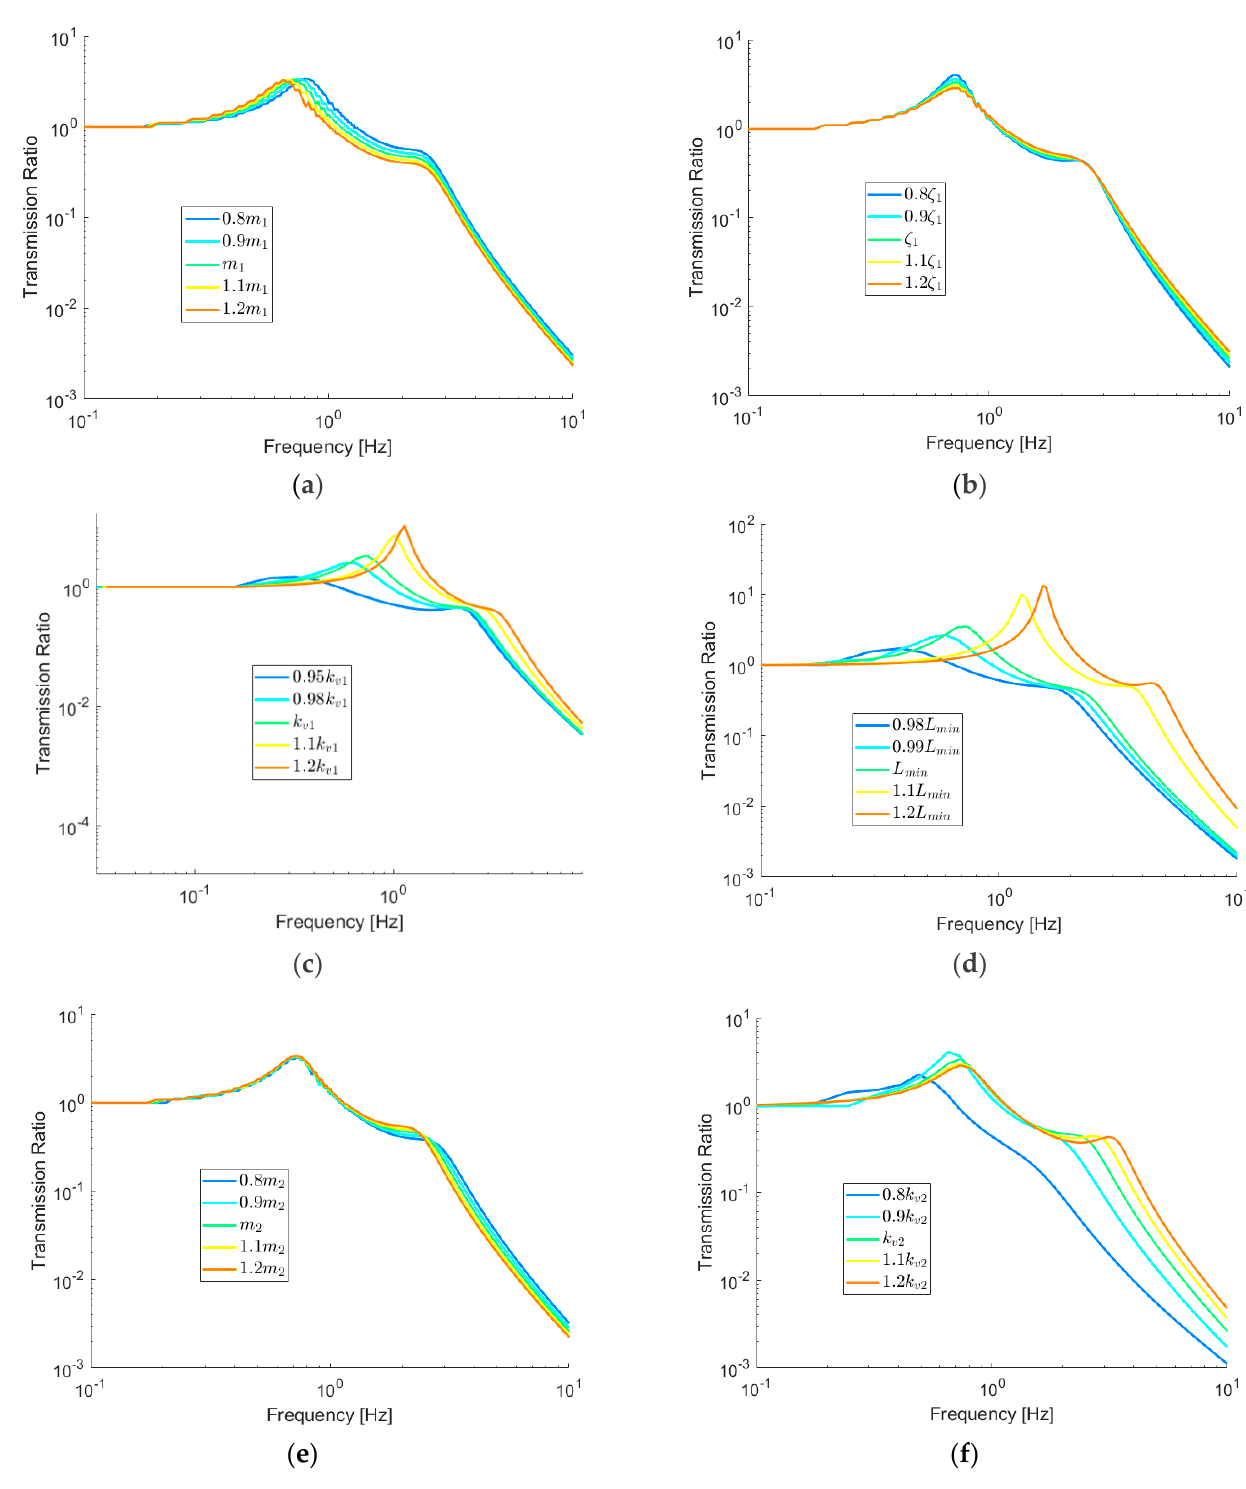
Figure 3. Sensitivity analysis for the 2DOF prototype system summarized in Table 1. ( a ) m 1 variation ±20%; ( b ) ζ 1 variation ±20%; ( c ) k v1 variation − 5% to +20%; ( d ) 𝐿 (cid:3040)(cid:3036)(cid:3041) variation − 2% to +20%, or L 0 variation − 20% to +2%; ( e ) m 2 variation ±20%; ( f ) k v2 variation ±20%. Table 1. Prototypes 1 and 2 physical properties. K vf refers to the vertical stiffness of the springs within the first half of the force–displacement plot. K vs refers to the stiffness within the second part of the plot. Refer to experimental procedures below for more detail.